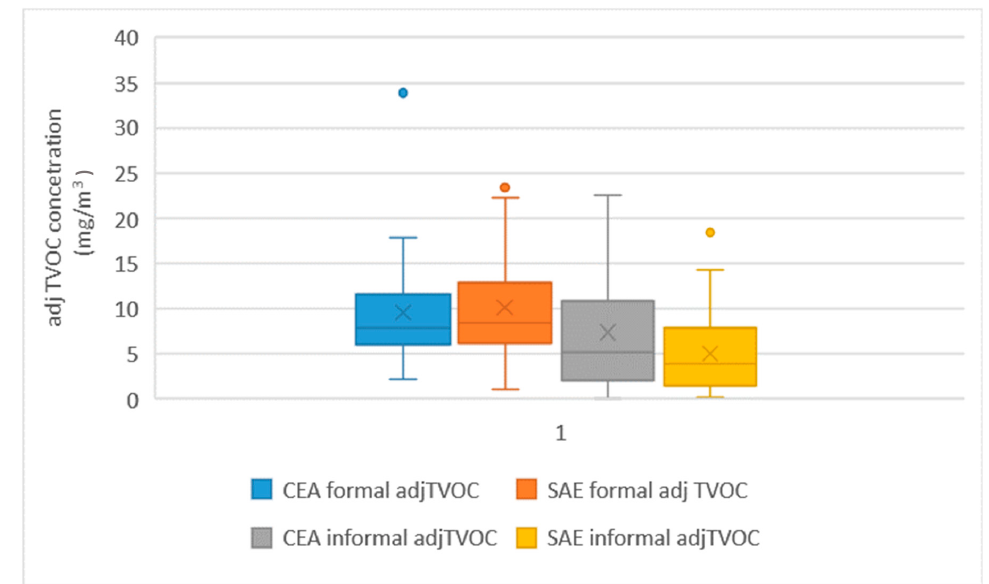
Figure 2. Box-plots of adjusted TVOC-concentrations (mg/m 3 ) for both exposure assessment re- gimes. The dots represent the outliers.